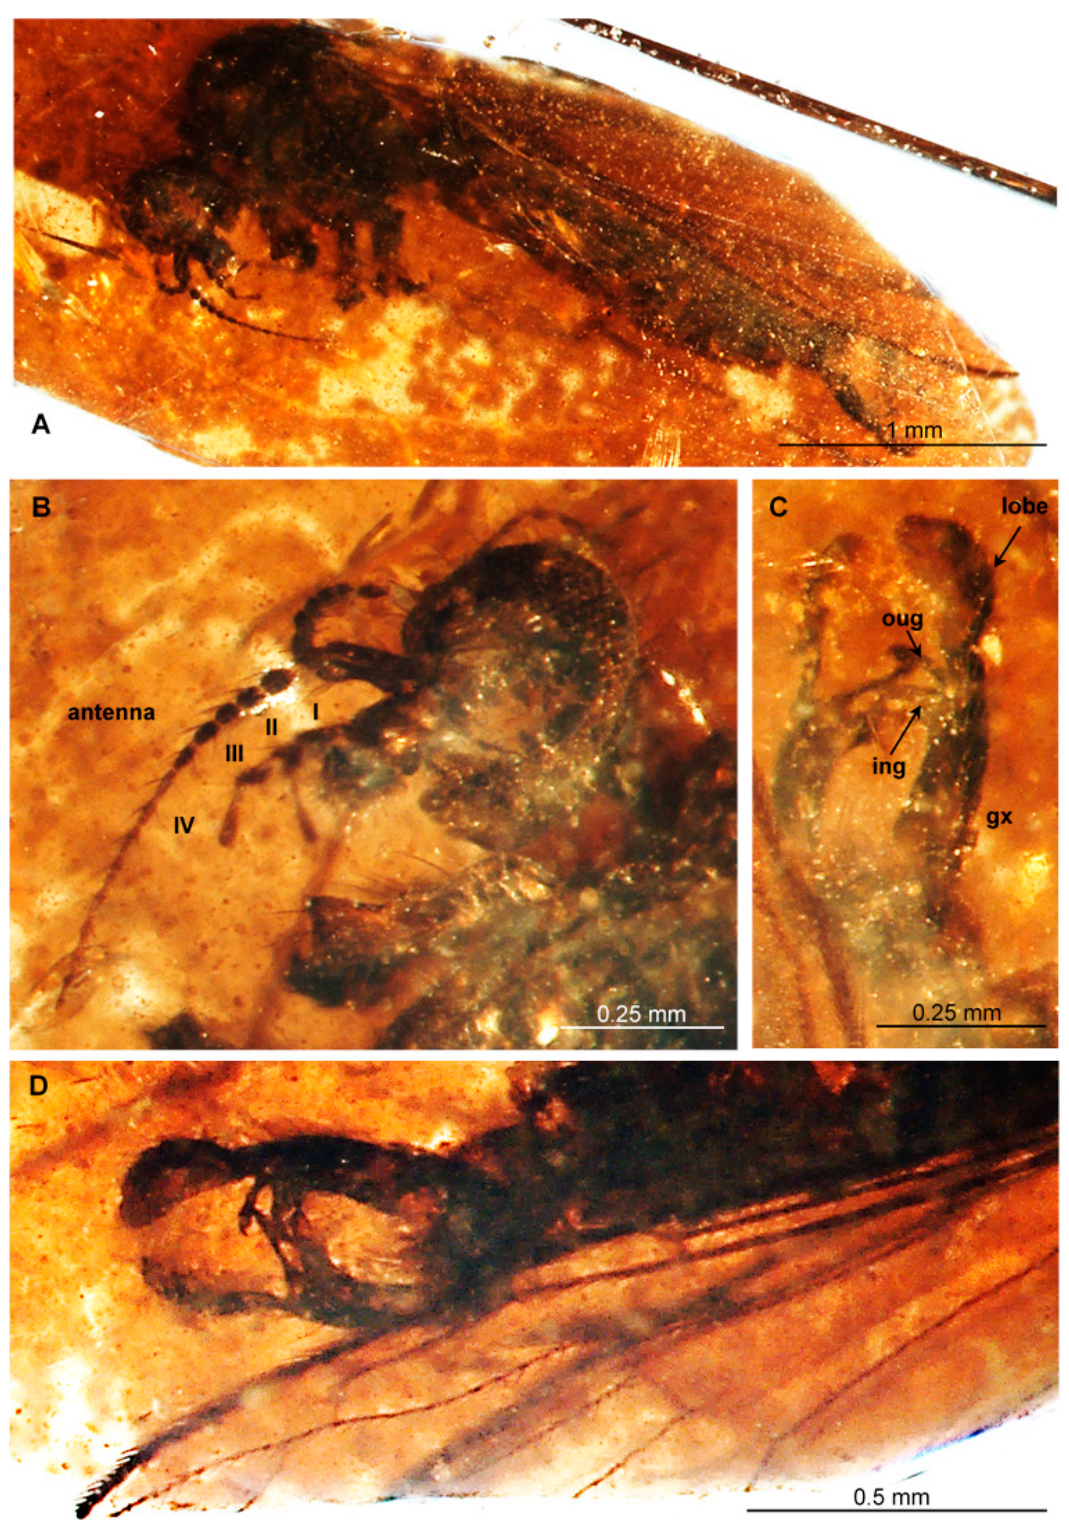
Figure 3. Trichoneura ( Cretalinea ) xavieri subgen. et sp. nov., holotype No. MCNA 9735 (male). ( A ) body, lateral view; ( B ) head with antenna and palpus visible; ( C ) hypopygium dorsal view; ( D ) hypopygium, ventral view. Abbreviations as in Figure 2. Figure 4. Discussion